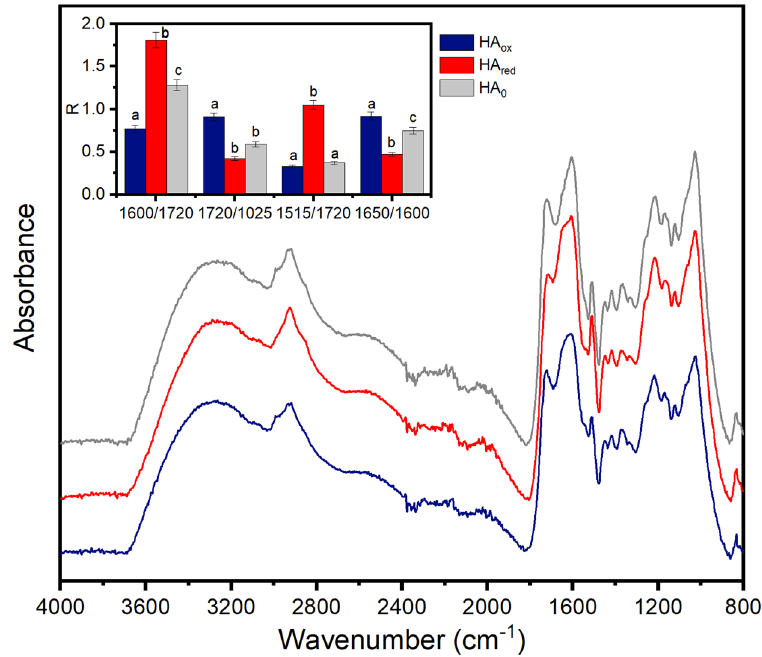
Figure 5. ATR-FTIR spectra of HA ox (blue), HA red (red) HA 0 (grey). Inset : relative intensity ratios (R)